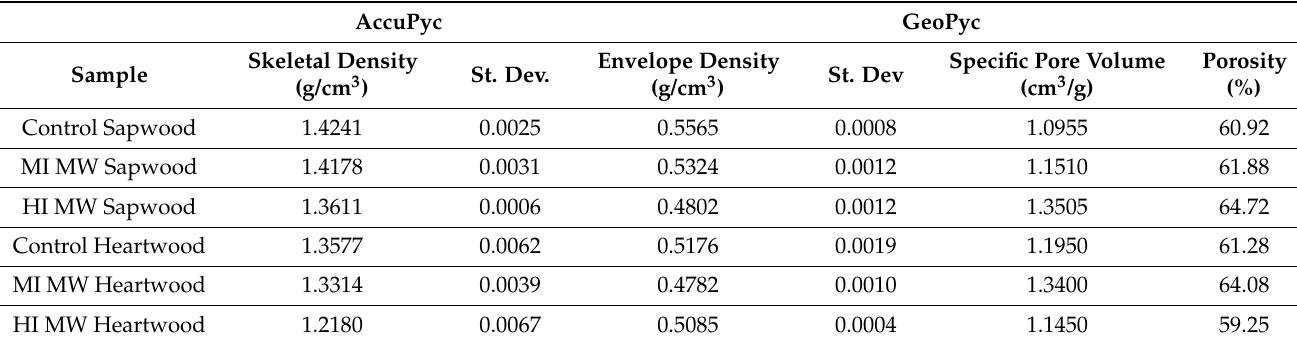
Table 1. Pycnometric density measurements. Microwave treatment (MW) was performed at moderate (MI) and high (HI) intensities on the Sapwood and Heartwood of Norway spruce ( Picea abies